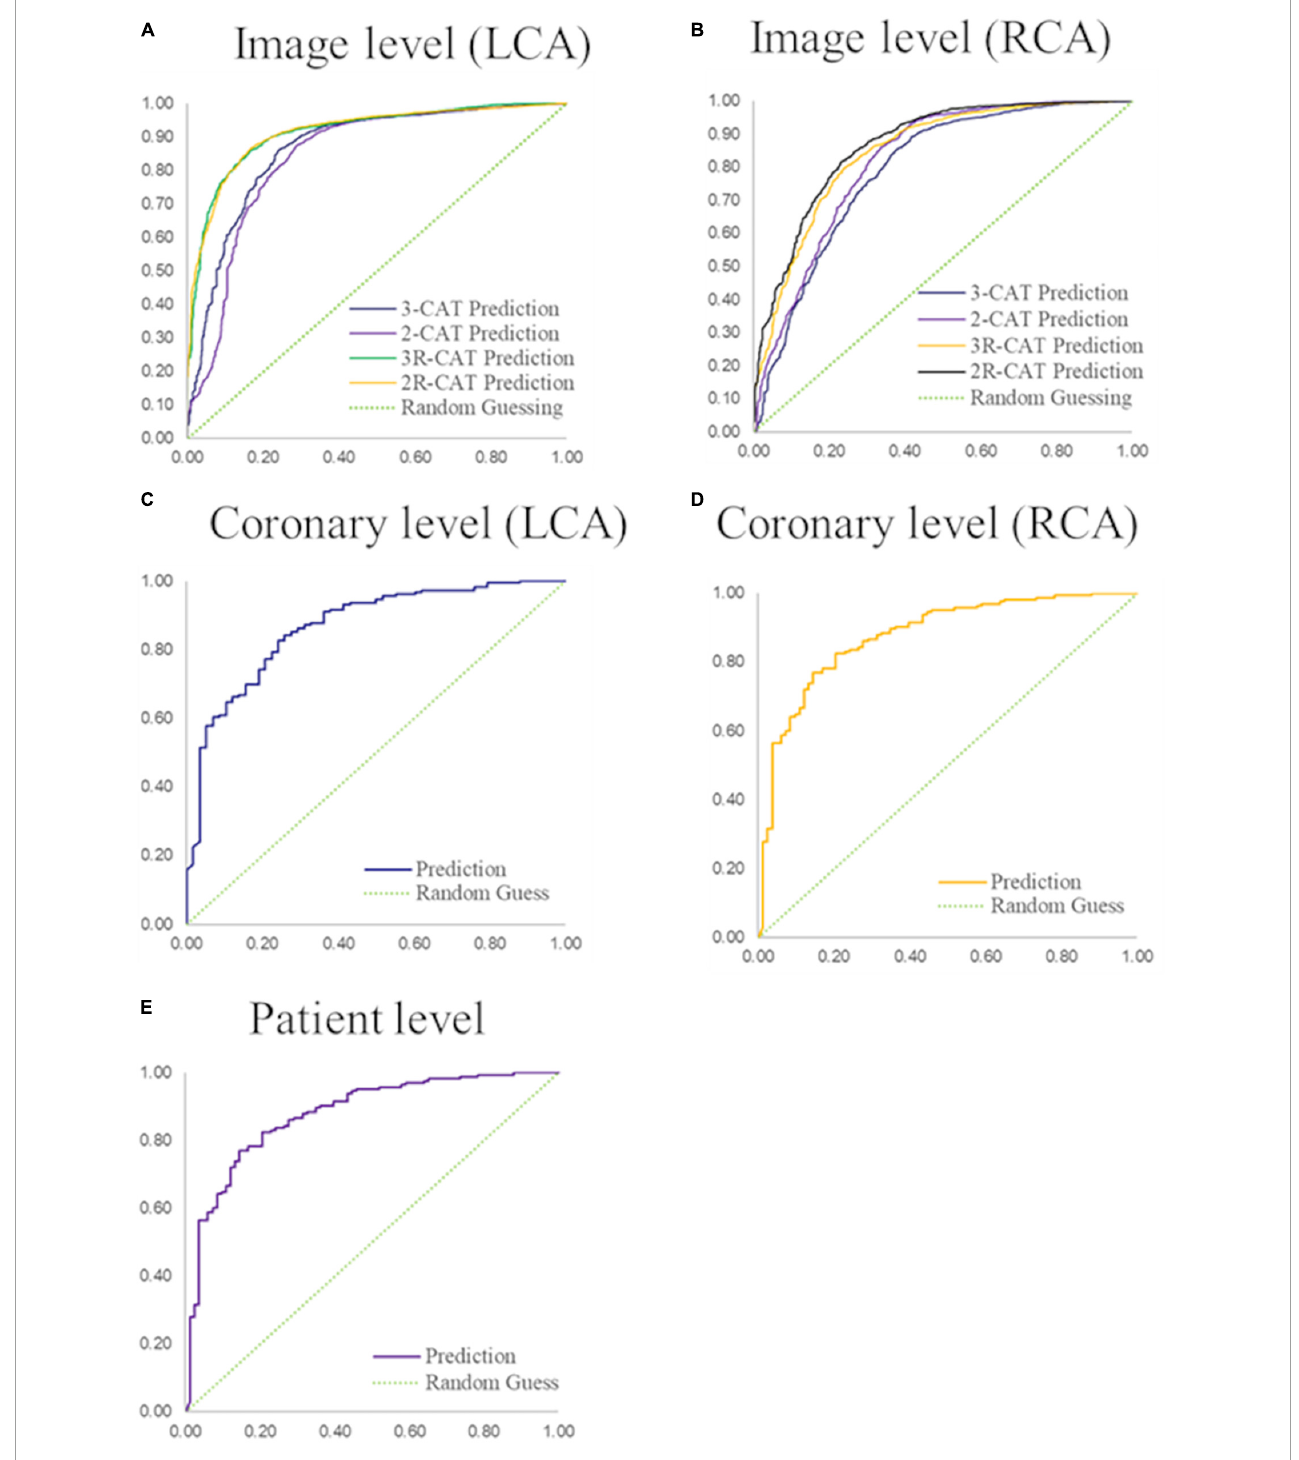
FIGURE3 Performance of coronary stenosis classifications in image, coronary artery, and patient levels. (A,B) ROC curves of image-level classification on 3-CAT and 2-CAT with and without redundancy training on LCA and RCA. (C,D) ROC curves of coronary artery level classification on LCA and RCA. (E) ROC curve of patient-level classification. The AUC values are summarized in Table 3 . RCA, right coronary artery; LCA, left coronary artery; AUC, area under the curve.